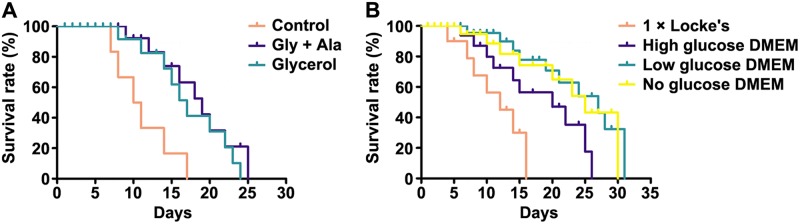
Survival curve of C. sinensis adults maintained on inorganic solutions and nutrient media.(A) Survival curve of adult flukes maintained on 1 × Locke’s (control), 1 × Locke’s containing 0.25% Gly and 0.25% Ala (Gly + Ala), as well as 1 × Locke’s containing 0.5% glycerol (glycerol). (B) Survival curve of adult flukes maintained on 1 × Locke’s and different DMEM. Survival curve was constructed using Kaplan-Meier analysis with the log-rank test.